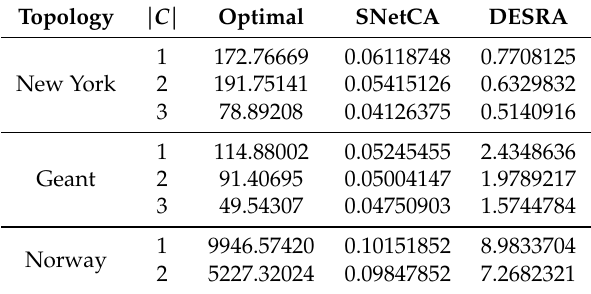
Table 3. Average execution time (s) using different numbers of controllers on real